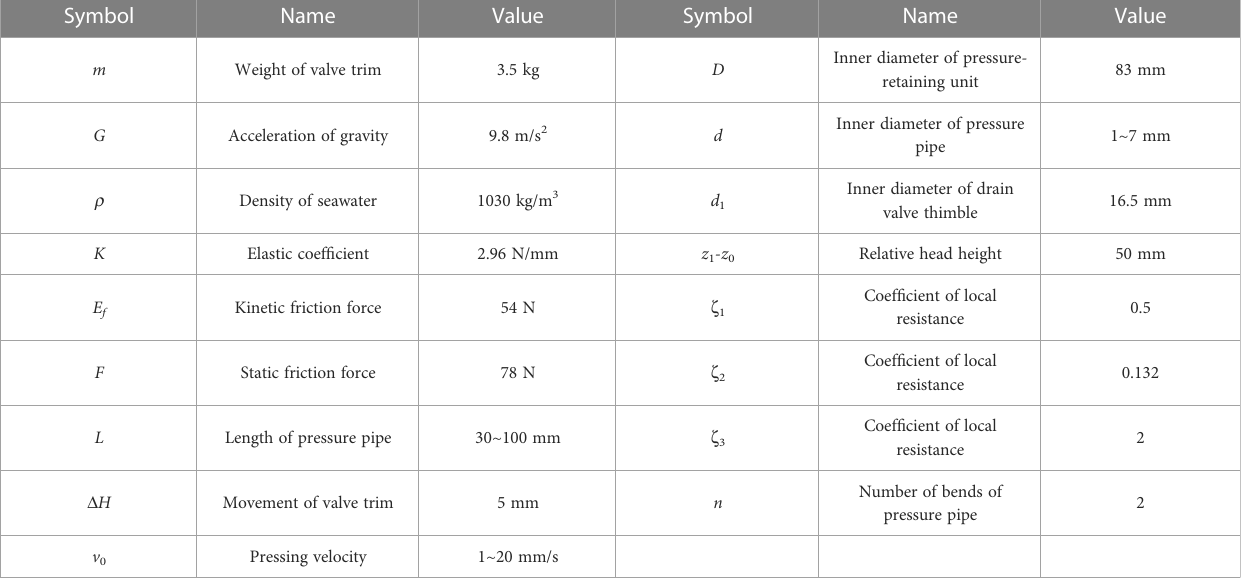
TABLE 1 Parameters of the kinematics model.